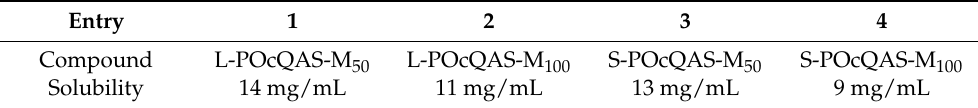
Table 2. Water solubility of L-POcQASs and